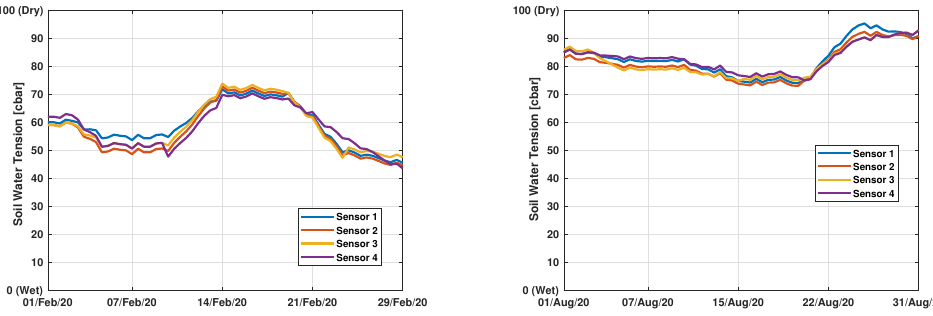
Figure 17. Site 2—Soil moisture averaged values: February 2020 ( left ) and August 2020 ( right ).